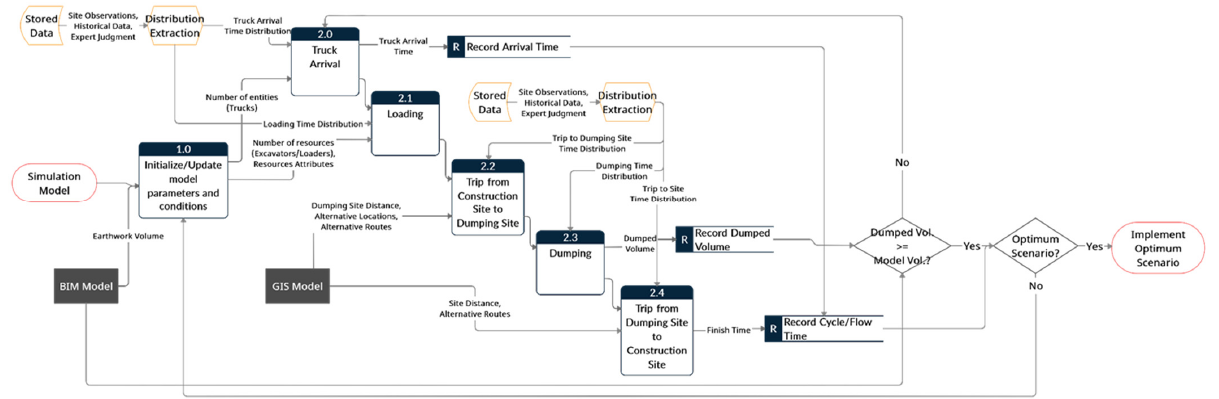
Figure 8. Data fl ow diagram for the earthwork operations simulation model. Figure 8. Data flow diagram for the earthwork operations simulation